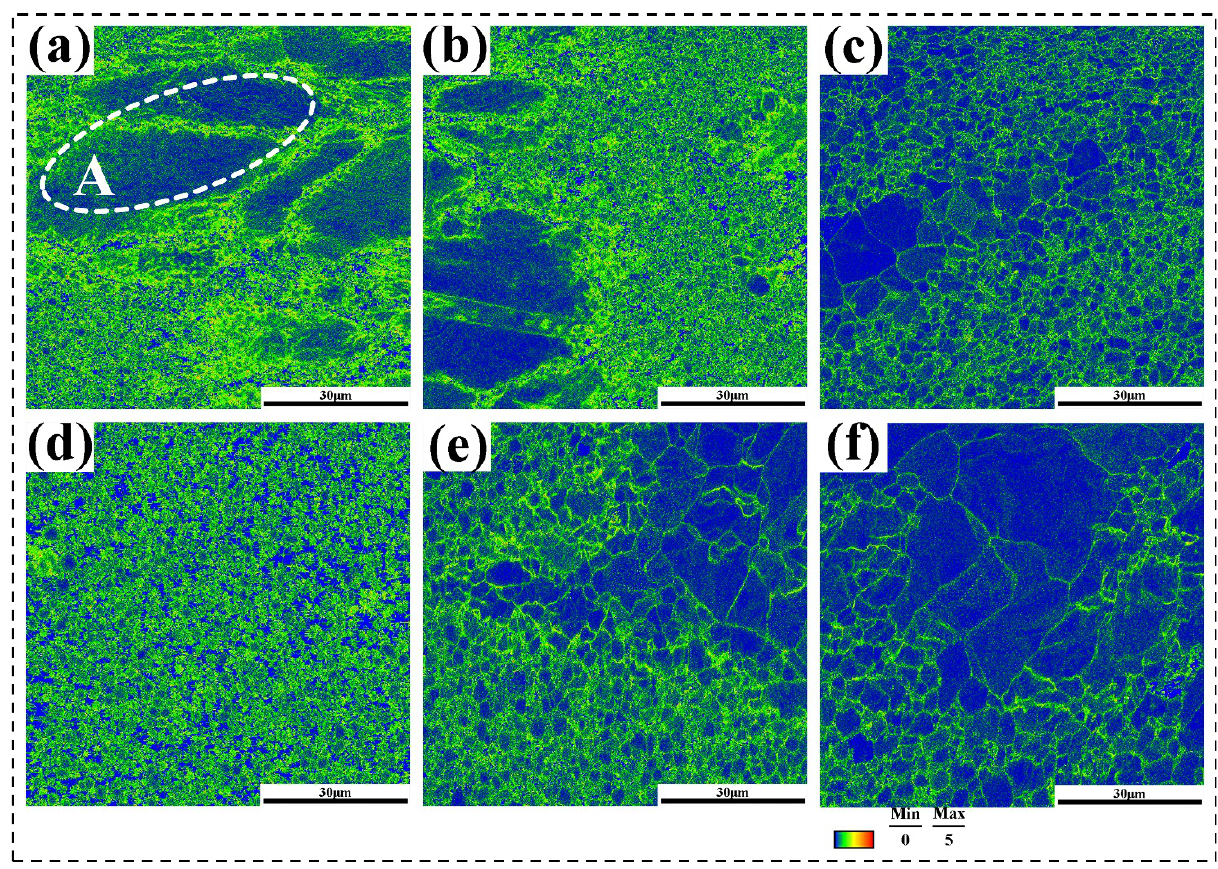
Figure 7. KAM maps of the studied superalloy obtained at: strain rate of 1 s − 1 with different deformation temperatures of ( a ) 1323, ( b ) 1373, and ( c ) 1423 K; deformation temperature of 1393 K with different strain rates of ( d ) 0.01, ( e ) 0.1, and ( f ) 1.0 s − 1 .